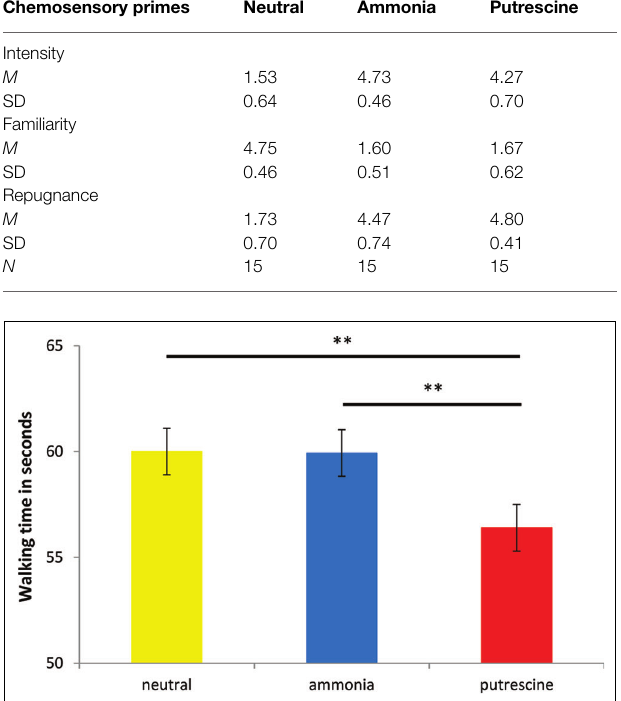
FIGURE 1 | The number of seconds it took participants to walk 80 m after exposure to the scent prime (Experiment 2). Asterisks denote that two groups differ at ** p <